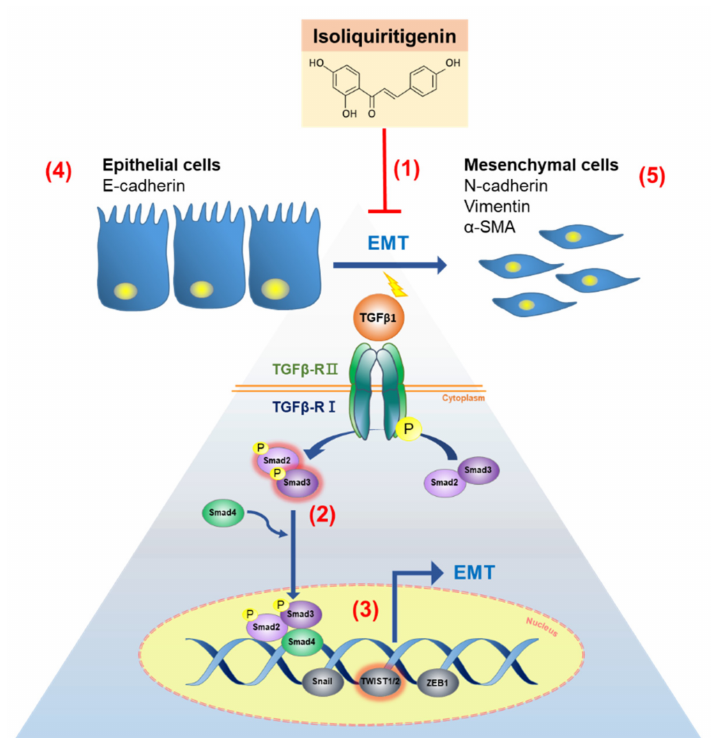
Figure 9. Schematic diagram of ISL effect on TGF- β 1 induced epithelial-mesenchymal transition (EMT) in human endometrial cancer. (1) ISL arrests the EMT progress via decreasing cells migration ability. (2,3) ISL reduces p-Smad3 expression and prevents its translocating into the nucleus and subsequent binding with TWIST1/2 (transcription factor) to regulate target gene expression. (4–5) ISL reverses the effect of TGF- β by restoring the loss on the epithelial marker (E-cadherin) and revoking the gain of mesenchymal markers (N-cadherin, vimentin, and α -SMA). Abbreviation: transforming growth factor beta (TGF- β ); epithelial–mesenchymal transition